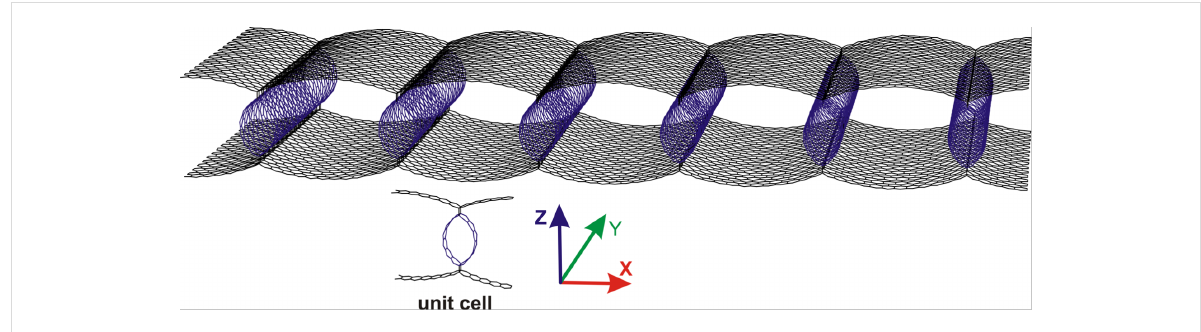
Figure 1: Topological model of 2D CNT-graphene hybrid nanocomposite.